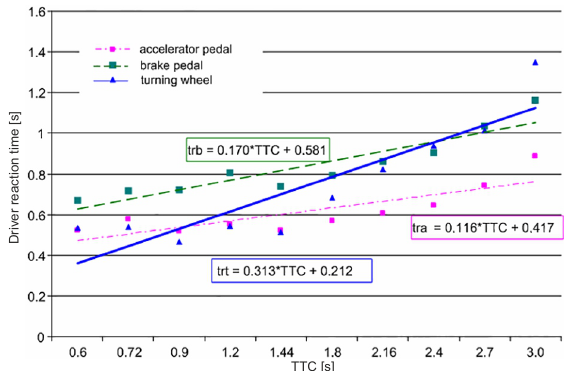
Table 4. Summary of test statistics |u| for reaction time on the steering wheel